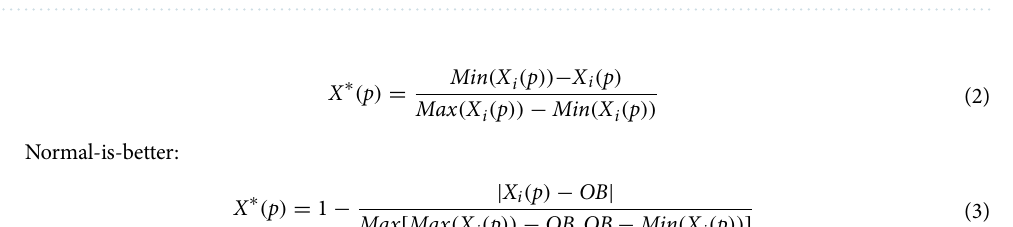
Figure 6. Flowchart of implementing the